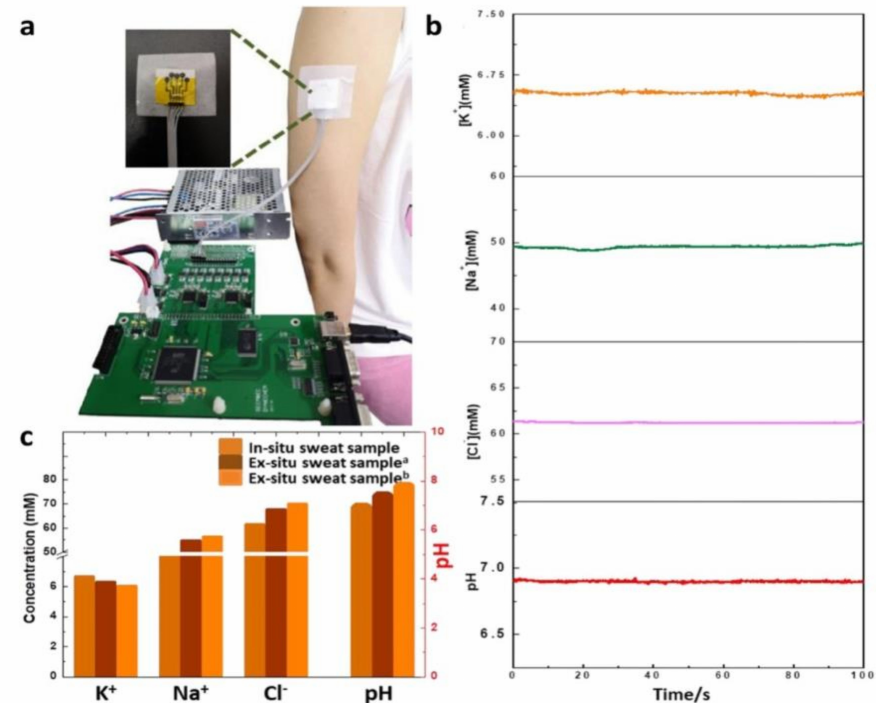
Figure 34. ( a ) An image of the detection instrument. ( b ) Results of in-sweat pH and target ion concentration real-time monitoring. ( c ) Sweat analysis findings in comparison to real-time test samples. (Reproduced from [577] with permission. Copyright 2019, Elsevier, Amsterdam, The Netherlands).